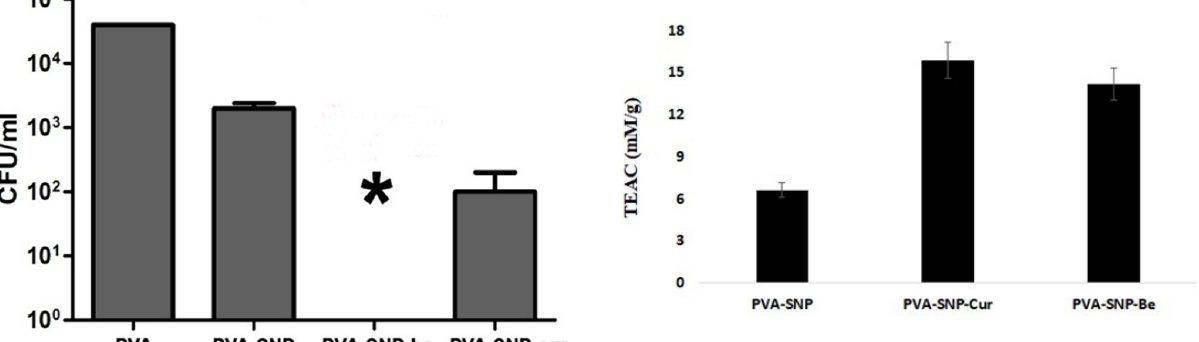
Figure 6. ( Left ) Antifouling activity of PVA, PVA-SNP, PVA-SNP-cur and PVA-SNP-ba against Listeria innocua . * Total inhibition of bacterial growth. ( Right ) Antioxidant activity (in Trolox equivalents) in the PVA-grafted films. The TEAC values were calculated using the original unmodified PVA films as a blank.